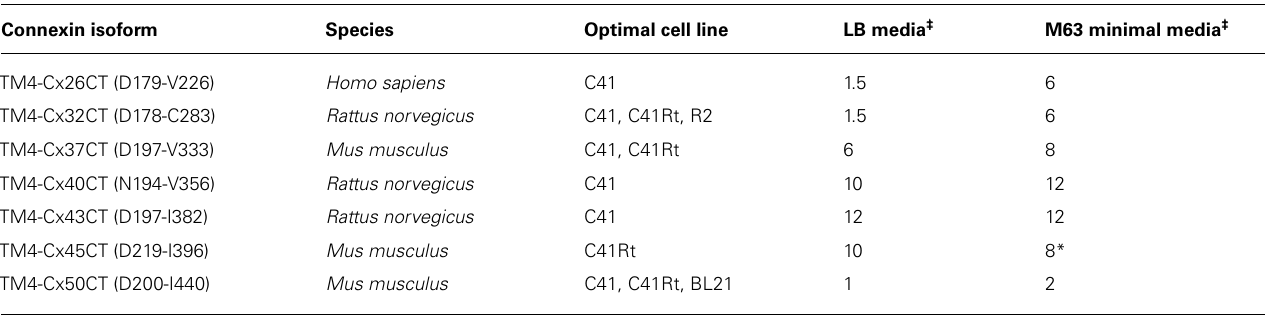
Abbreviations used for E. coli competent cell stains: C41, C41(DE3); R2, Rosetta2(DE3)pLysSRARE2; C41Rt, C41(DE3)pLys; BL21, BL21(DE3). ‡ Liters of bacterial culture required to produce a 300 μ L sample at 1 mM concentration. *ISOGRO required forTM4-Cx45CT expression in minimal